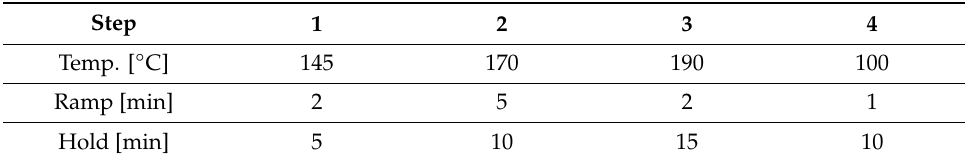
Table 2. Temperature program of